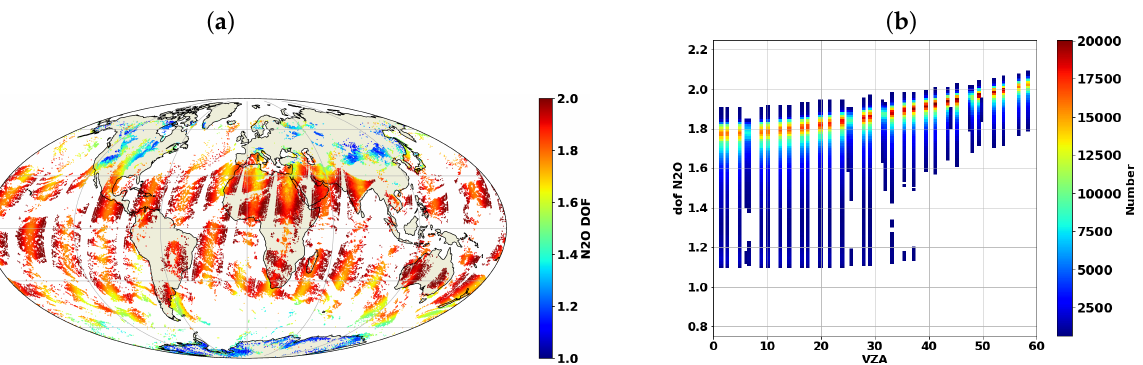
Figure 10. ( a ) N 2 O DOF for 15 December 2018 during day-time and ( b ) N 2 O retrieval DOF as a function of satellite VZA for global data in December 2018. The result is similar for other